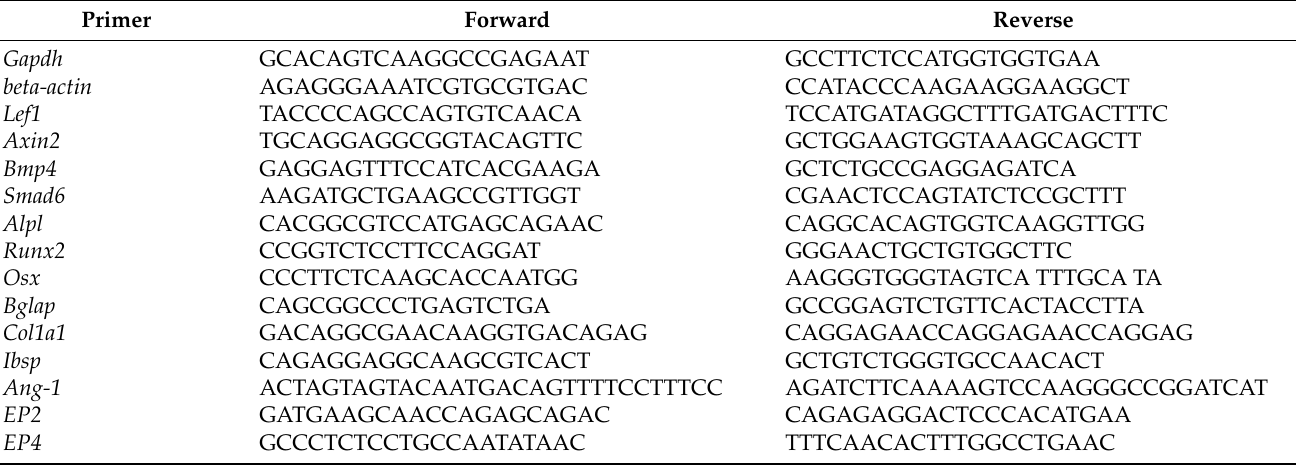
Table 1. Sequences of primers used for RT-PCR